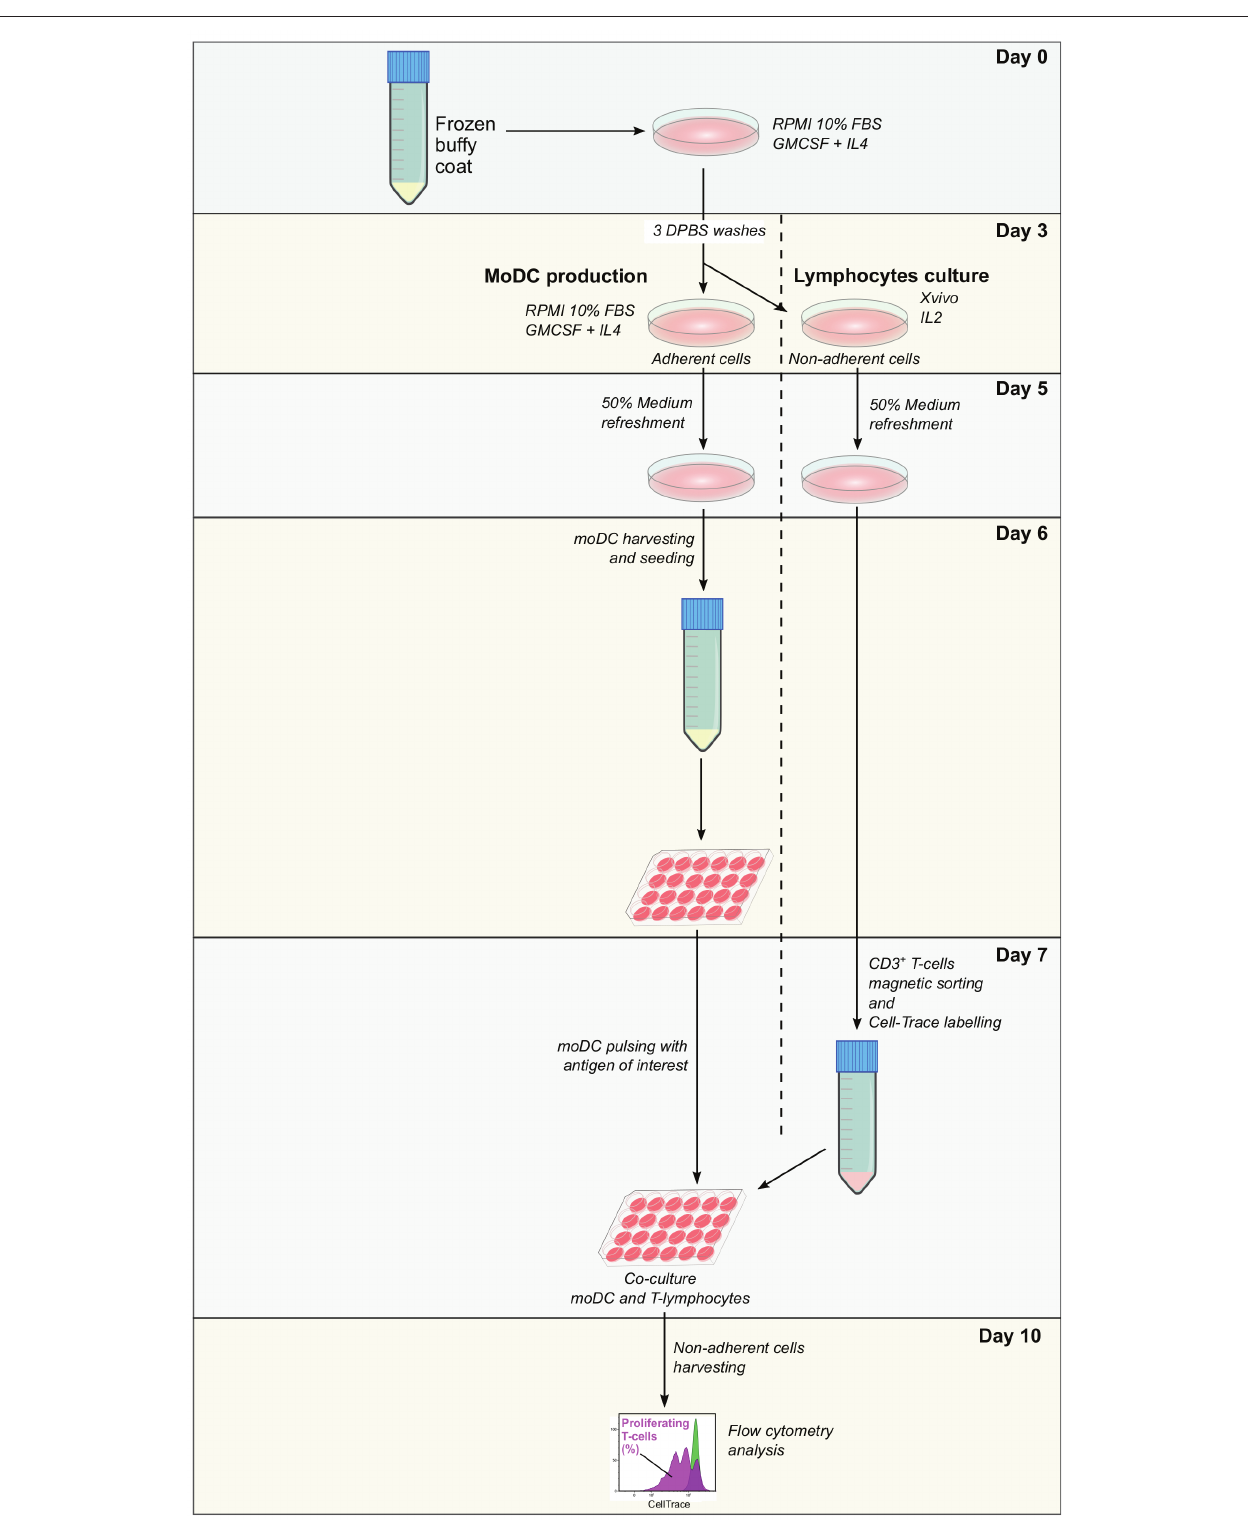
Frontiers in Veterinary Science |